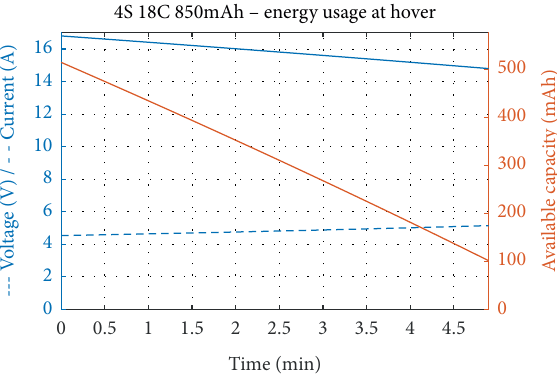
Figure 13: Battery behaviour of GTQ Mini during